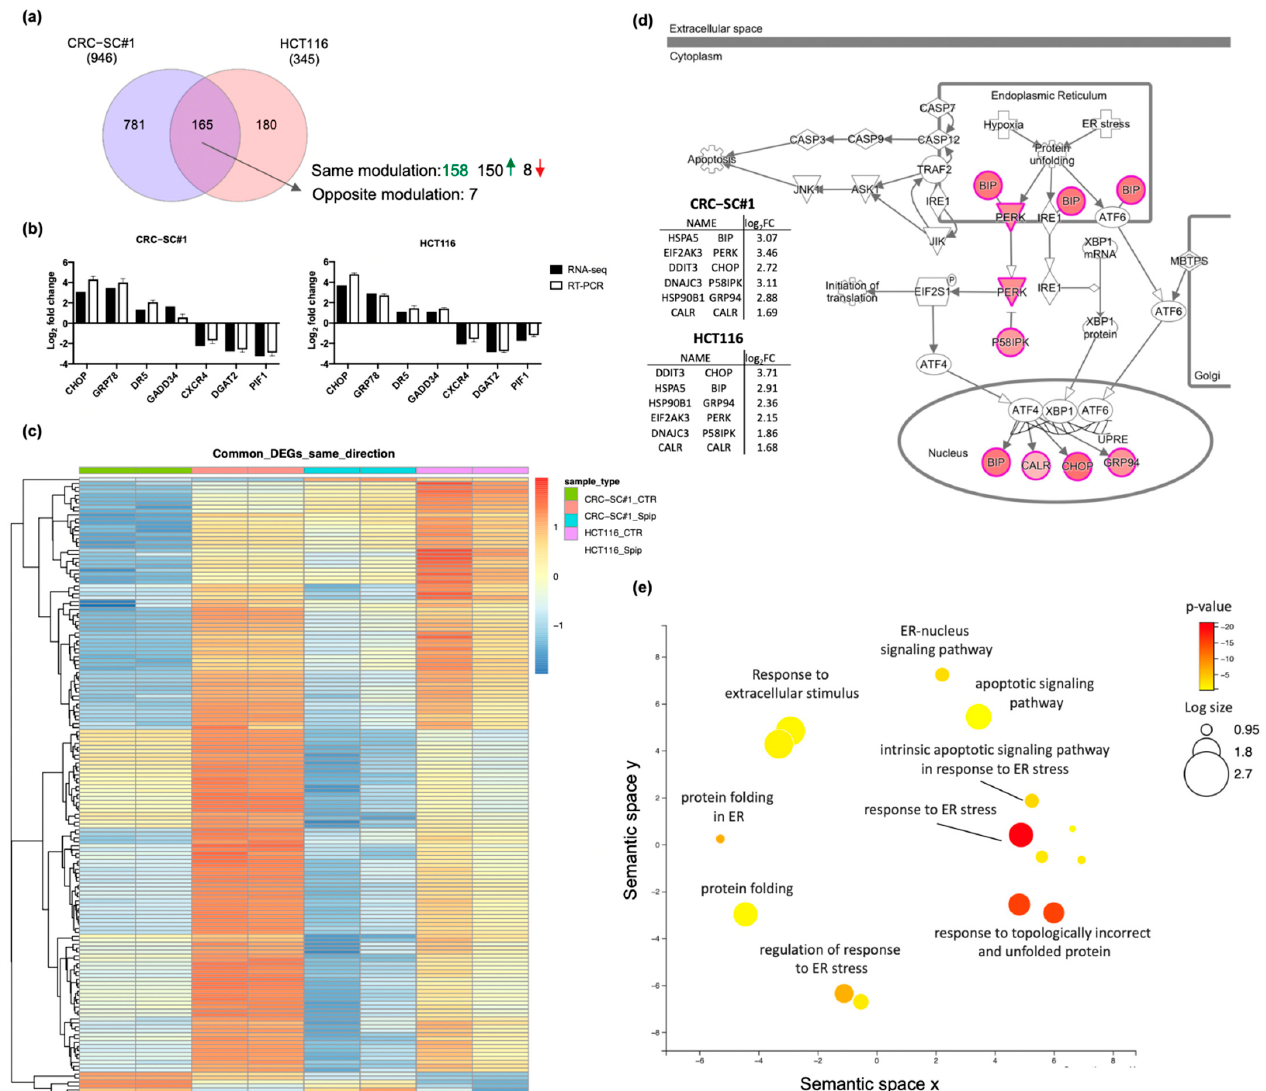
Figure 7. Spiperone induces ER stress in CRC cells. Venn diagram showing the number of DEGs between HCT116 and CRC-SC#1 cells ( a ). Log2FC validation of RNA-Seq analysis through RT-PCR in CRC-SC#1 and HCT116 cells ( b ). Heatmap showing unsupervised hierarchical clustering of the 158 common DEGs between the two comparison groups (HCT116-Spip vs. HCT116-CTR and CRC- SC#1-Spip vs. CRC-SC#1-CTR) that have the same trend ( c ). ER Stress molecular pathways from IPA Ingenuity software, and Log2FC of the upregulated genes. Red-colored molecules are upregulated in both of the two comparison groups and, therefore, upregulated after the treatment with spiperone in HCT116 and CRC-SC#1 cells ( d ). Semantic plot of the common enriched biological processes ( e ).